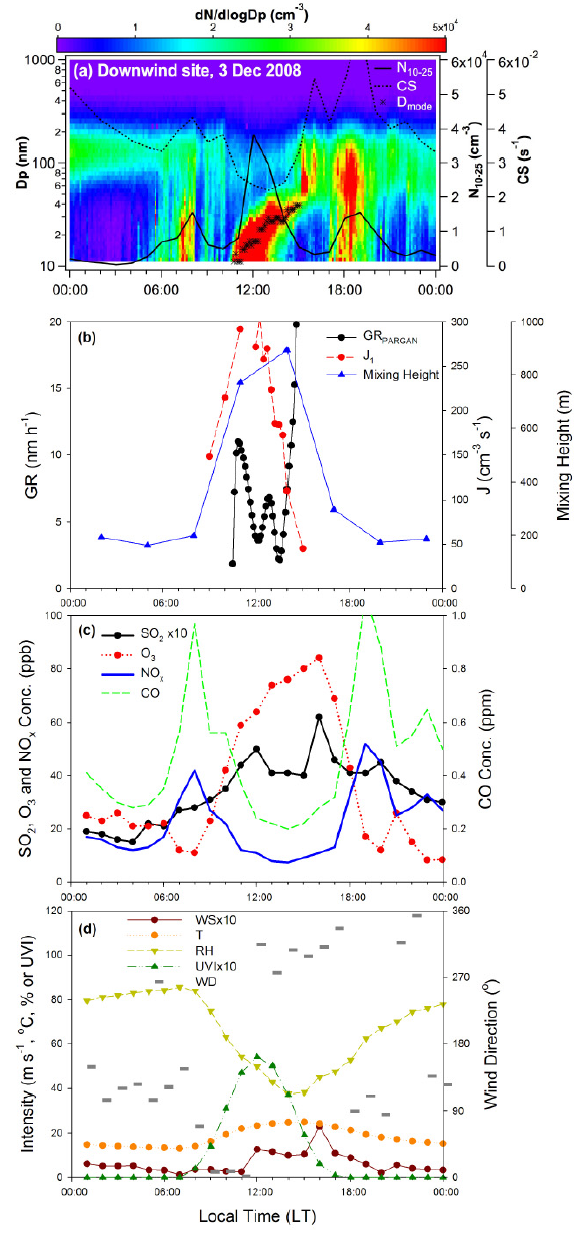
Fig. 4. The same as Fig. 3, except this is for a midday NPF and growth event on the 3 December